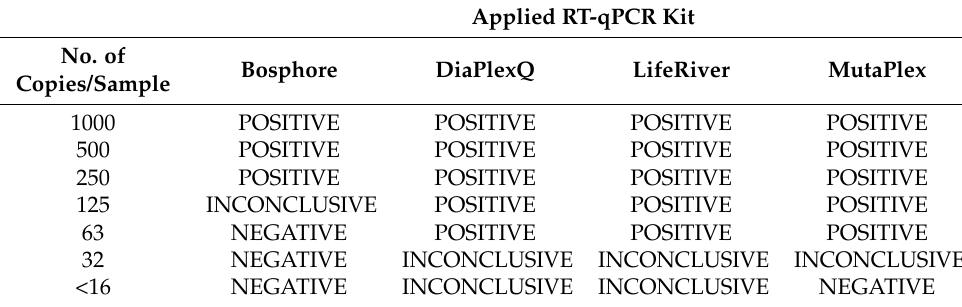
Table 3. A minimal number of detected SARS-CoV-2